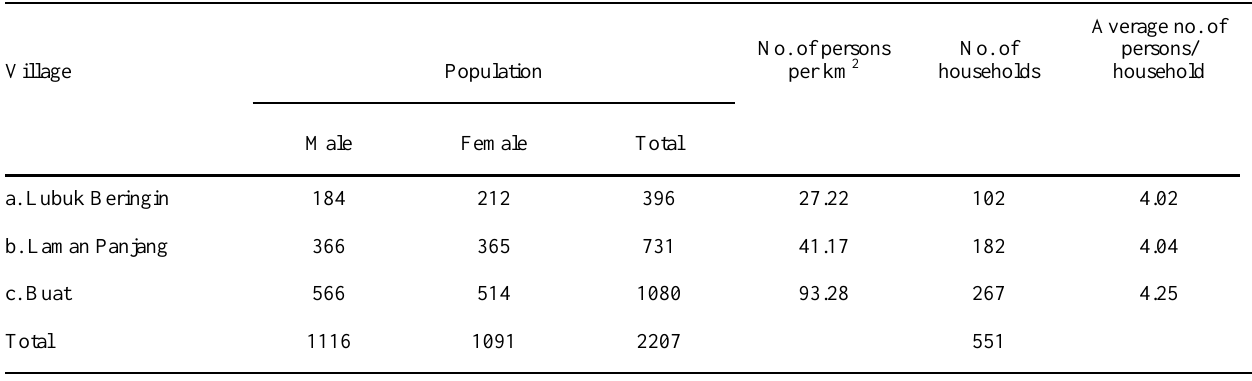
Table 2. Population and number of households in the study site (Source: 2003 Statistics of Rantau Pandan Sub-District) Village Population